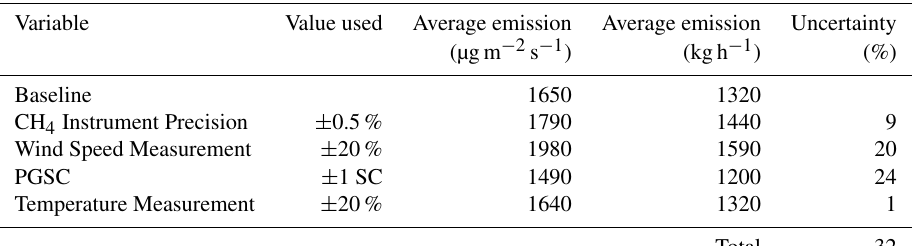
Table 5. Uncertainty analysis conducted on the annual methane emission from the landfill at the Waterbeach Waste Management Park as calculated within the Gaussian plume modelling